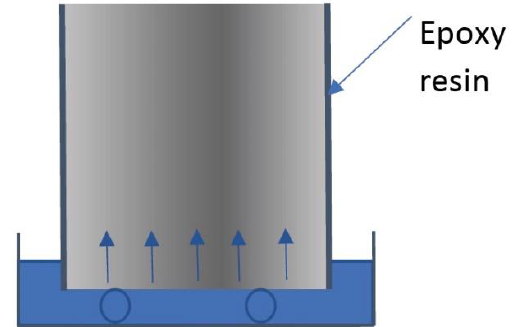
Figure 1. Setup for the unidirectional water absorption